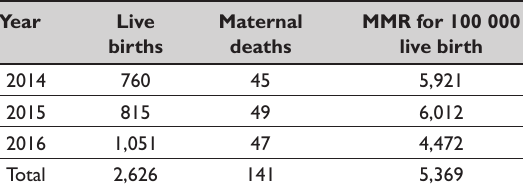
Table 2: Annual evolution of maternal mortality Ratios in Dori Hospital, Burkina Faso, 2014-2016